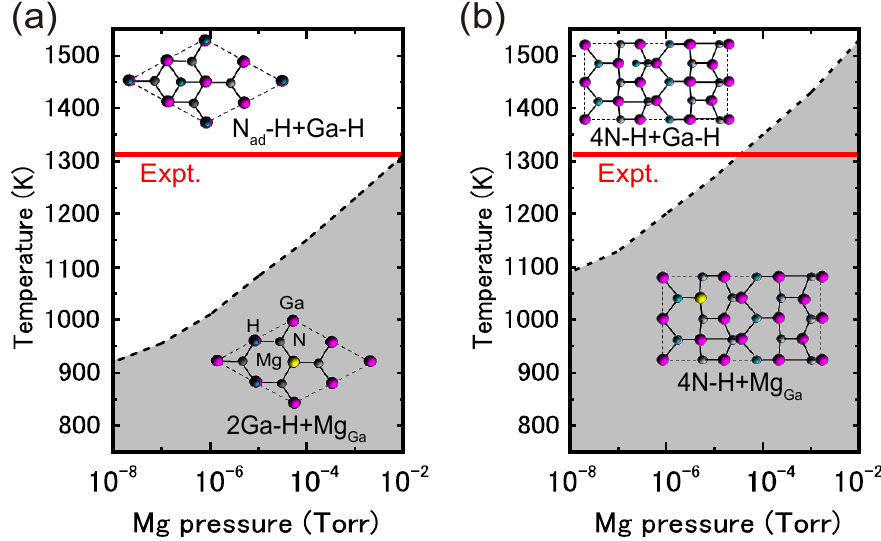
Mg-free surfaces at the N-rich limit ( μ = − 1.24 eV) as a function of Mg BEP on the Ga ( a ) GaN(0001) and ( b ) GaN (cid:4666)11(cid:3364)01(cid:4667) surfaces. The Mg-incorporated surfaces are stabilized in the shaded regions. The GaN MOVPE growth temperature was provided by References [131,132] and is denoted by red